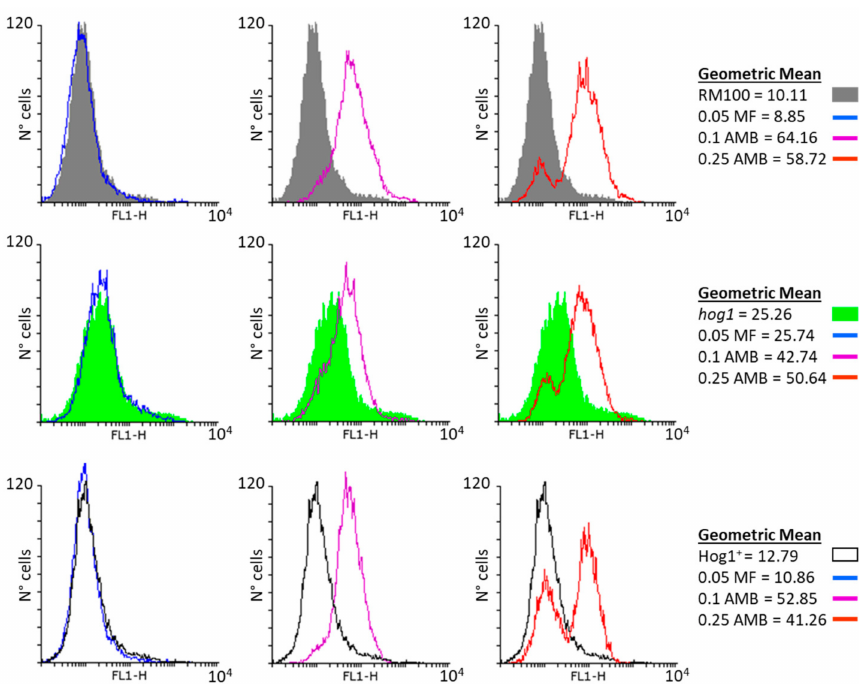
Figure 3. E ff ect of the antifungal treatment on the mitochondrial membrane potential in RM100, hog1 mutant, and Hog1 + reintegrant strains. Yeast cells were treated with MF (0.05 mg / L) and AMB (0.1 and 0.25 mg / L) in PBS for 1 h at 37 ◦ C. Then, they were incubated with 20 µ M Rhodamine 123 for 30 min, and the membrane potential was determined by flow cytometry. The upper row shows the mitochondrial membrane potential of RM100 untreated (basal level) and after antifungal treatments. The row in the middle shows the mitochondrial membrane potential of the hog1 mutant untreated (basal level) and after antifungal treatments and the lower row shows the mitochondrial membrane potential of the Hog1 + reintegrant strain. Histograms represent the cell number with respect to the green (FL1) fluorescence intensity. The data shown are representative of three independent experiments. The geometric means of the fluorescence intensity are indicated in the text box. Filled gray histograms belong to the basal wild-type RM100 strain, filled green histogram belongs to the hog1 mutant, and white-filled black lines belong to the basal Hog1 + reintegrant. For other details, see Figure